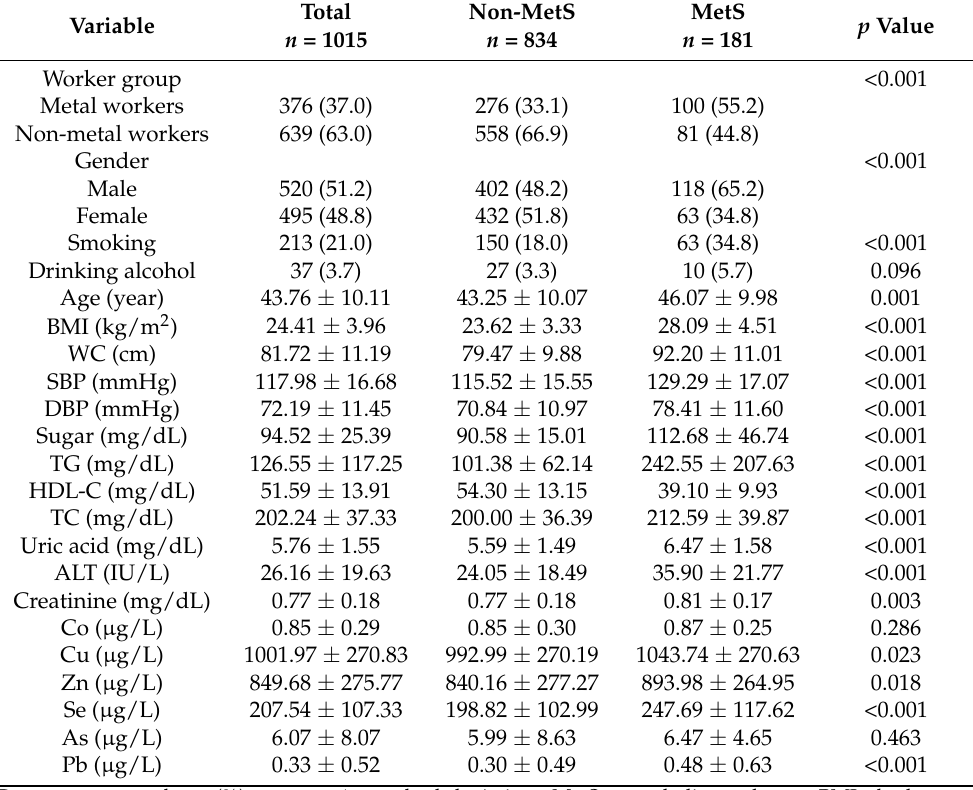
Table 1. Demographic characteristics, physical and biochemical data, and plasma metal concentra- tions in the participants with and without